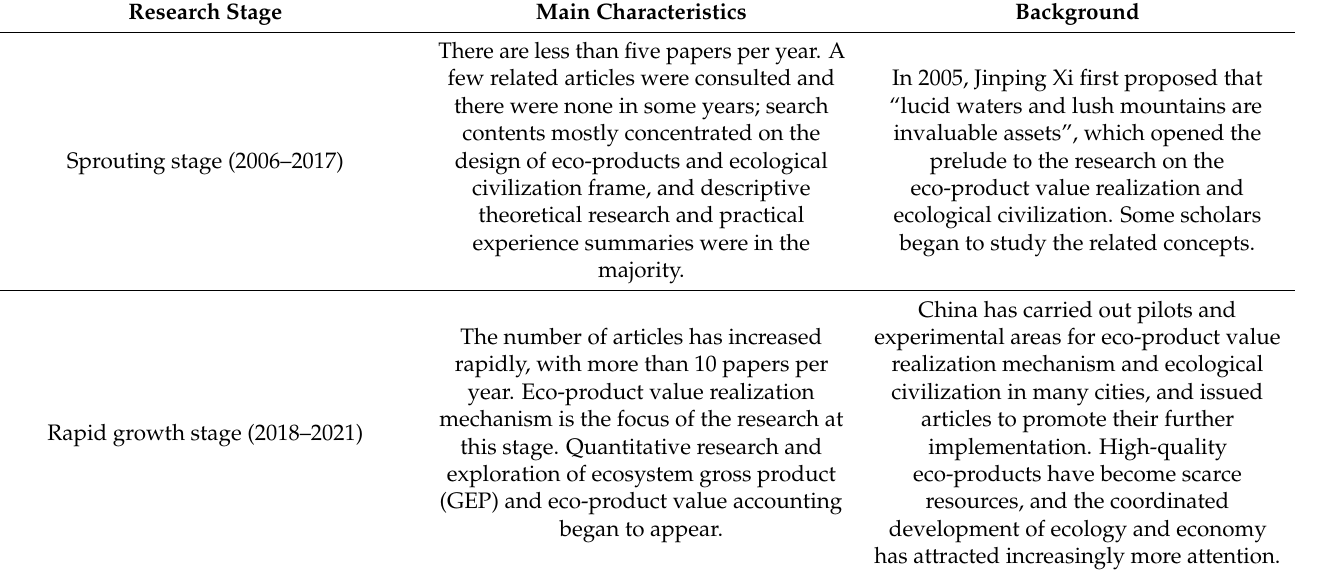
Table 1. Division of the research